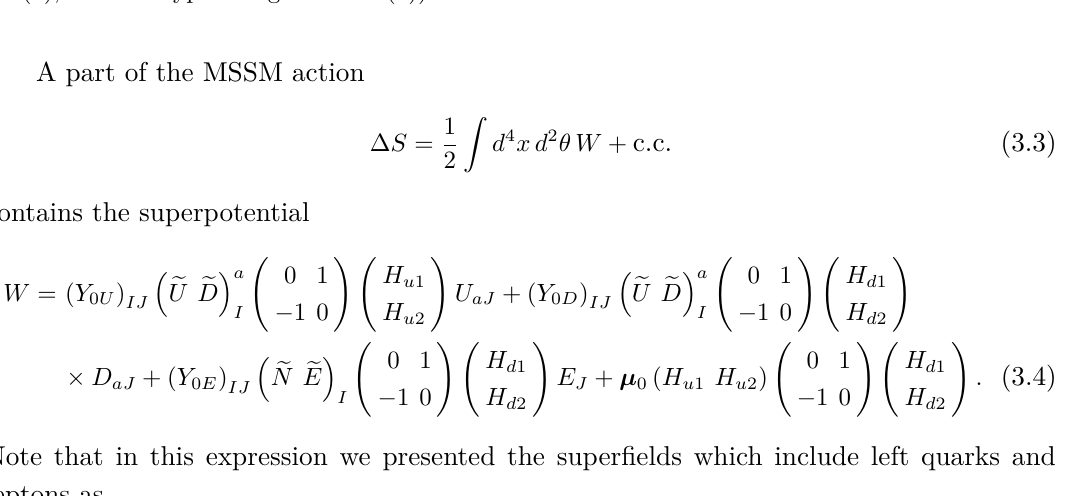
Table 1 . Chiral matter superfields and their quantum numbers (representations for SU (3) and SU (2) , and the hypercharge Y for U (1) ) in